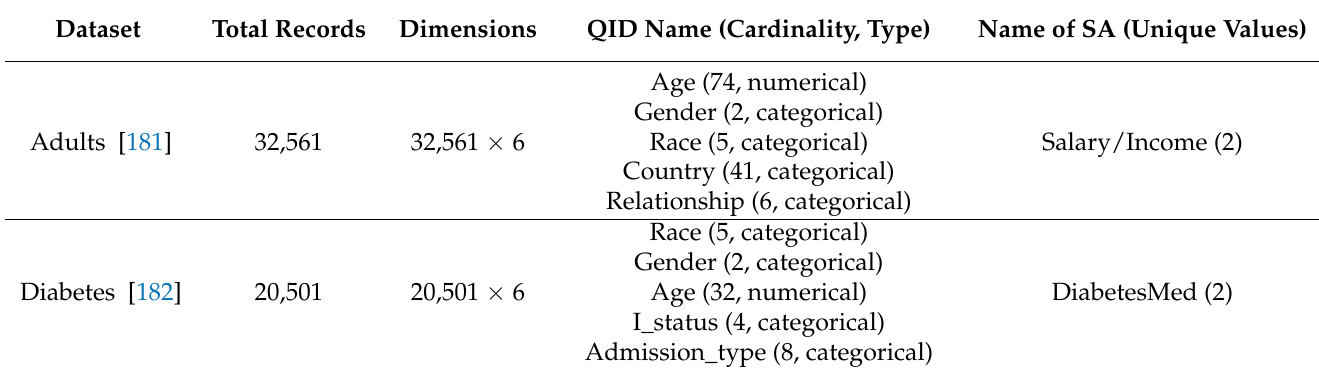
Table 2. Details of the datasets used in the experiment